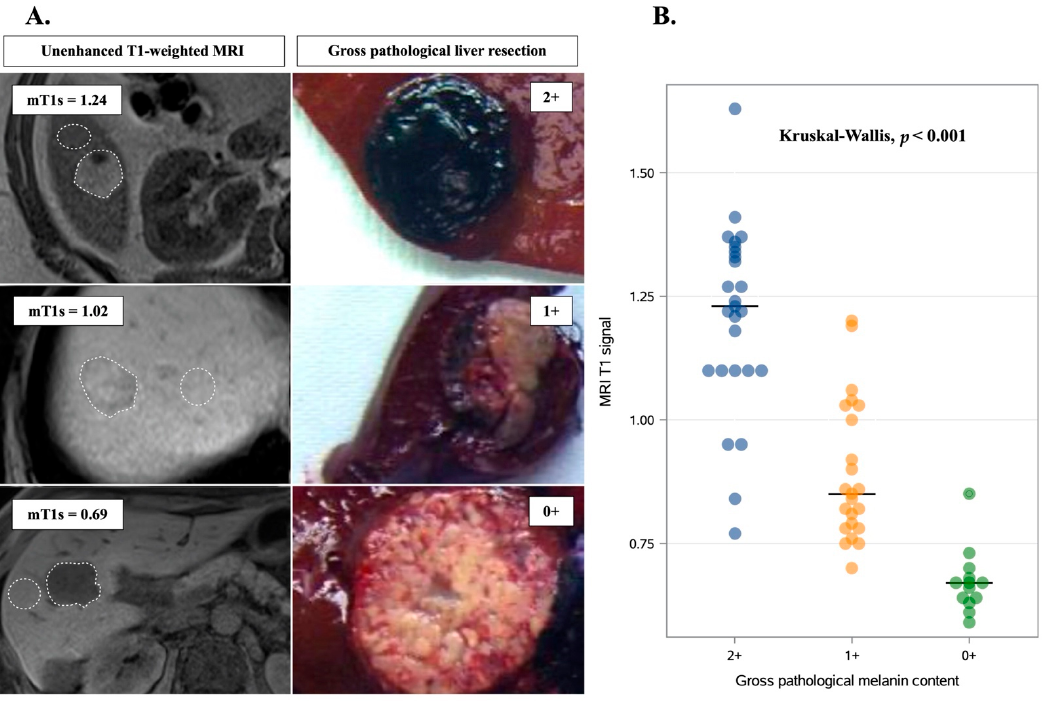
Figure 1. Association between gross pathological and MRI melanin quantification. ( A ) Illustrative examples showing the correlation between preoperative, unenhanced, T1-weighted MRI and postoperative gross pathological scoring of pigmentation in uveal melanoma liver metastases. White dashed lines indicate regions of interest that were manually drawn in tumors and in adjacent liver parenchyma. Melanin pathological quantification was assessed visually and graded as follows: 0+ (hypopigmented), 1+ (mixed pigmented), and 2+ (strongly pigmented). ( B ) Correlation of gross pathological features and MRI melanin quantification. Horizontal lines indicate median